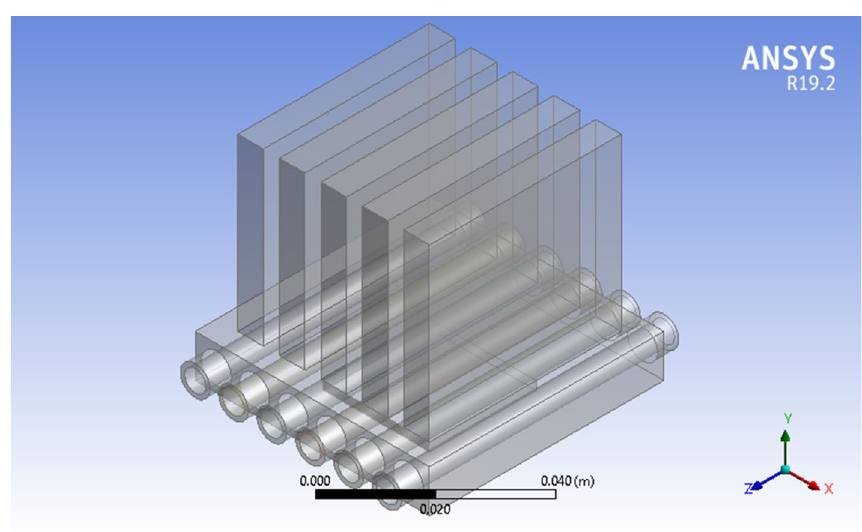
Figure 3. Microchannel heat sink geometry view created by ANSYS.